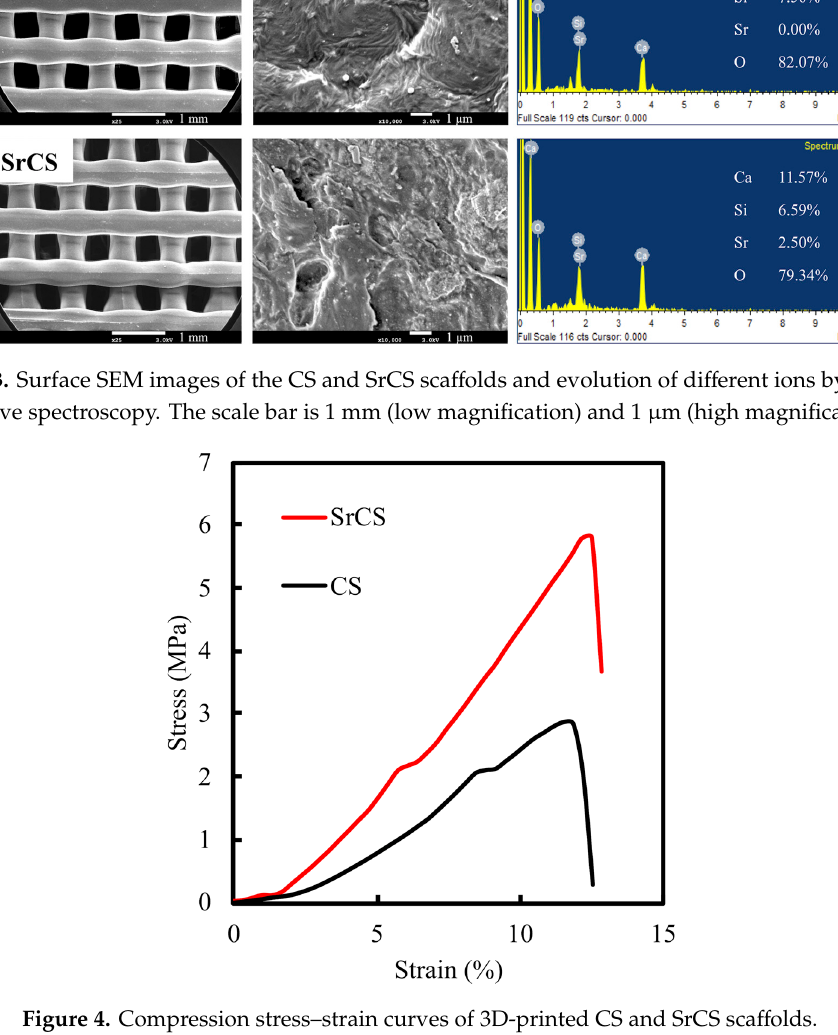
Figure 4. Compression stress–strain curves of 3D-printed CS and SrCS scaffolds.